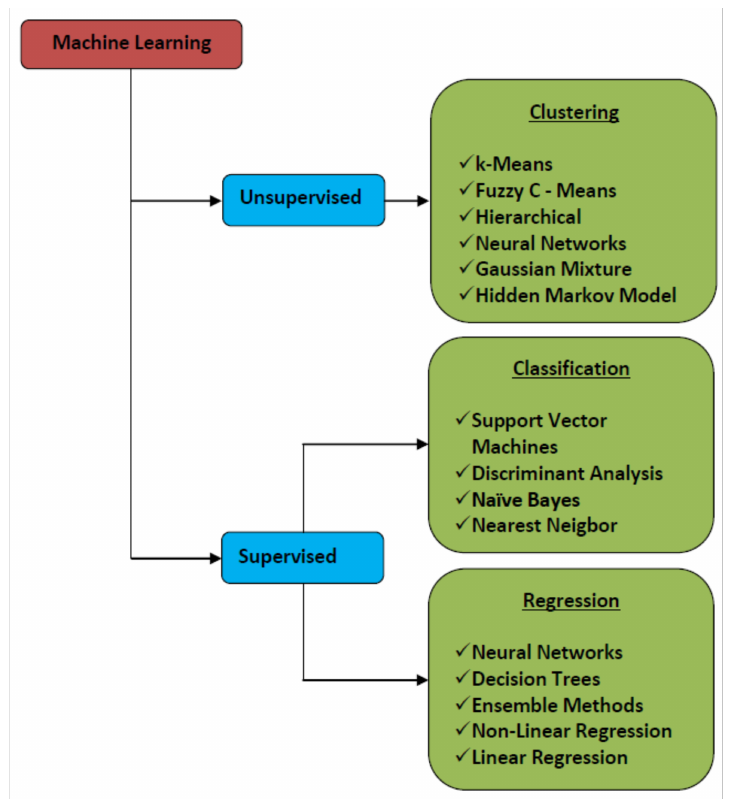
Figure 1. Artificial intelligence categorization [20,22–24].